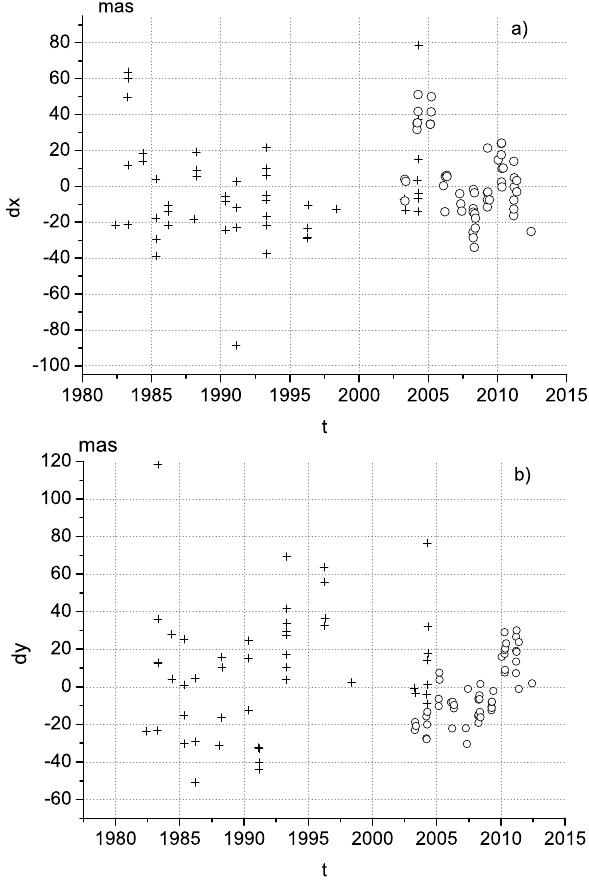
Fig. 1. ADS 9173. Deviations relative to the orbit of outer pair AB — input data for the astrometric orbit determinations. Notations are as follows: a) — dx(t), b) — dy(t); photographic observations are crosses, CCD observations are circles.